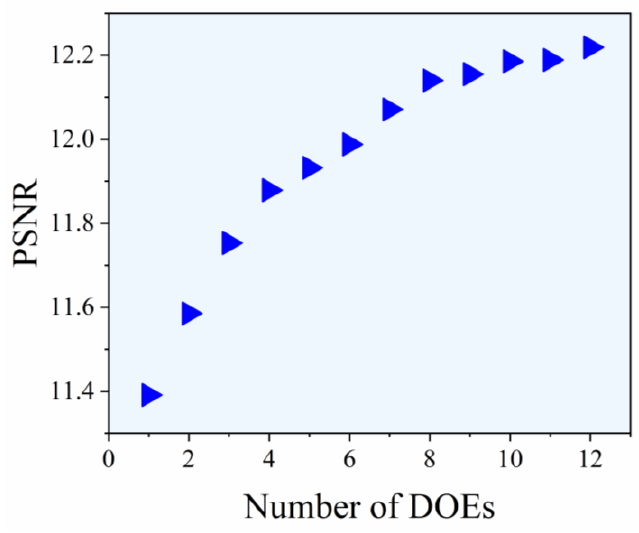
Figure 11. Relationship between the number of the DOEs and PSNR by using the proposed system.